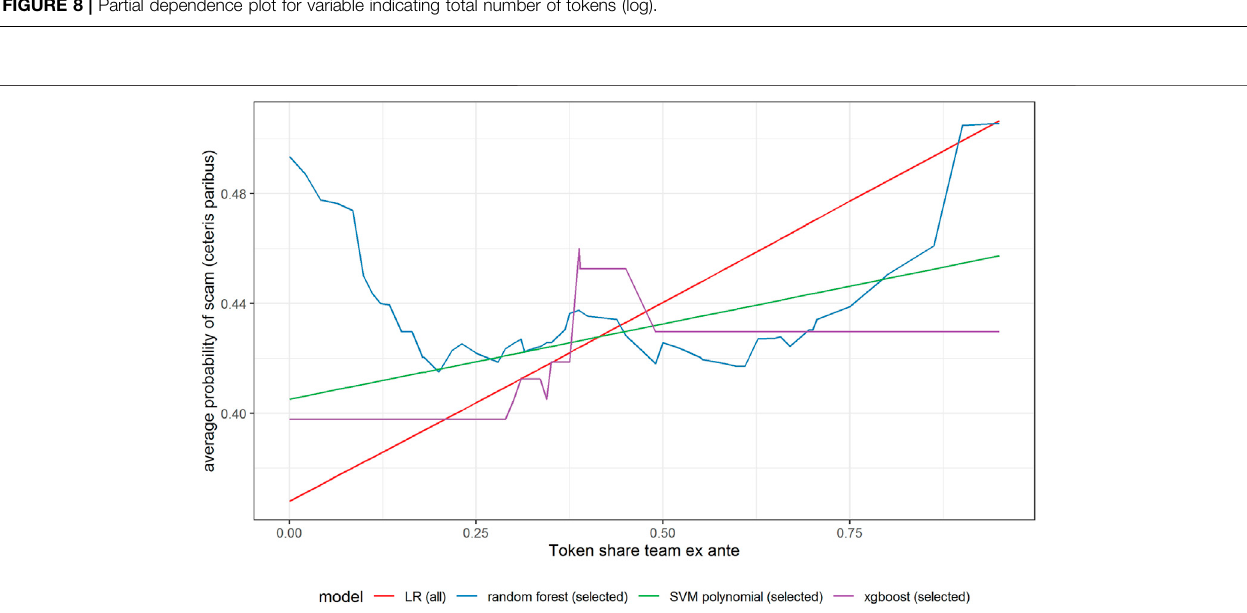
FIGURE 9 | Partial dependence plot for variable indicating the share of tokens for the team (ex-ante).